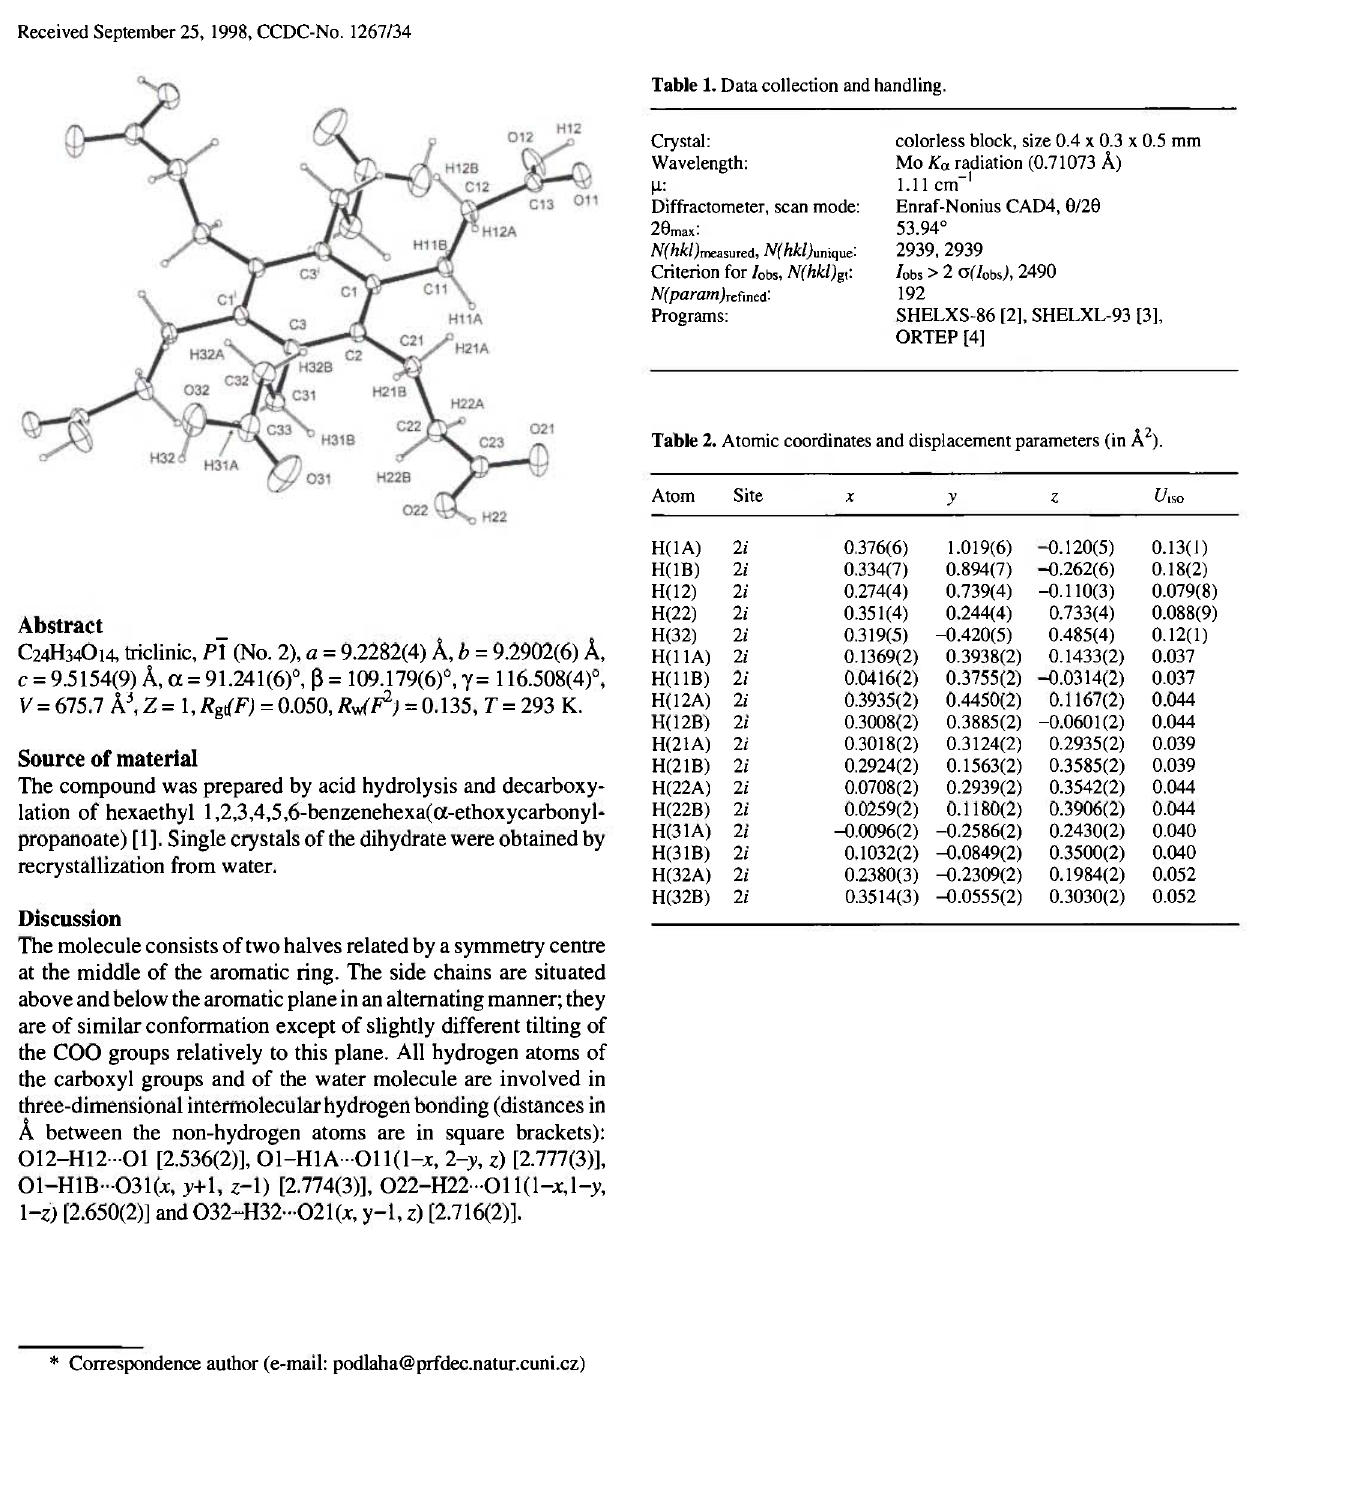
Table 1. Data collection and handling.